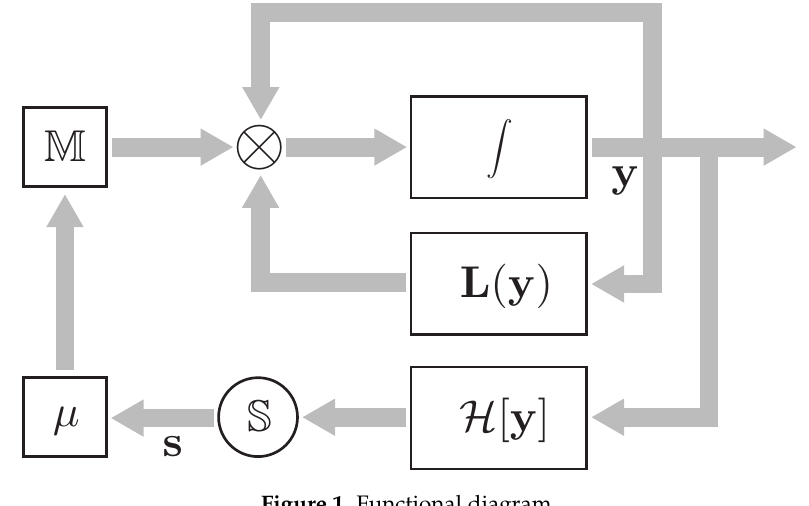
Figure 1. Functional